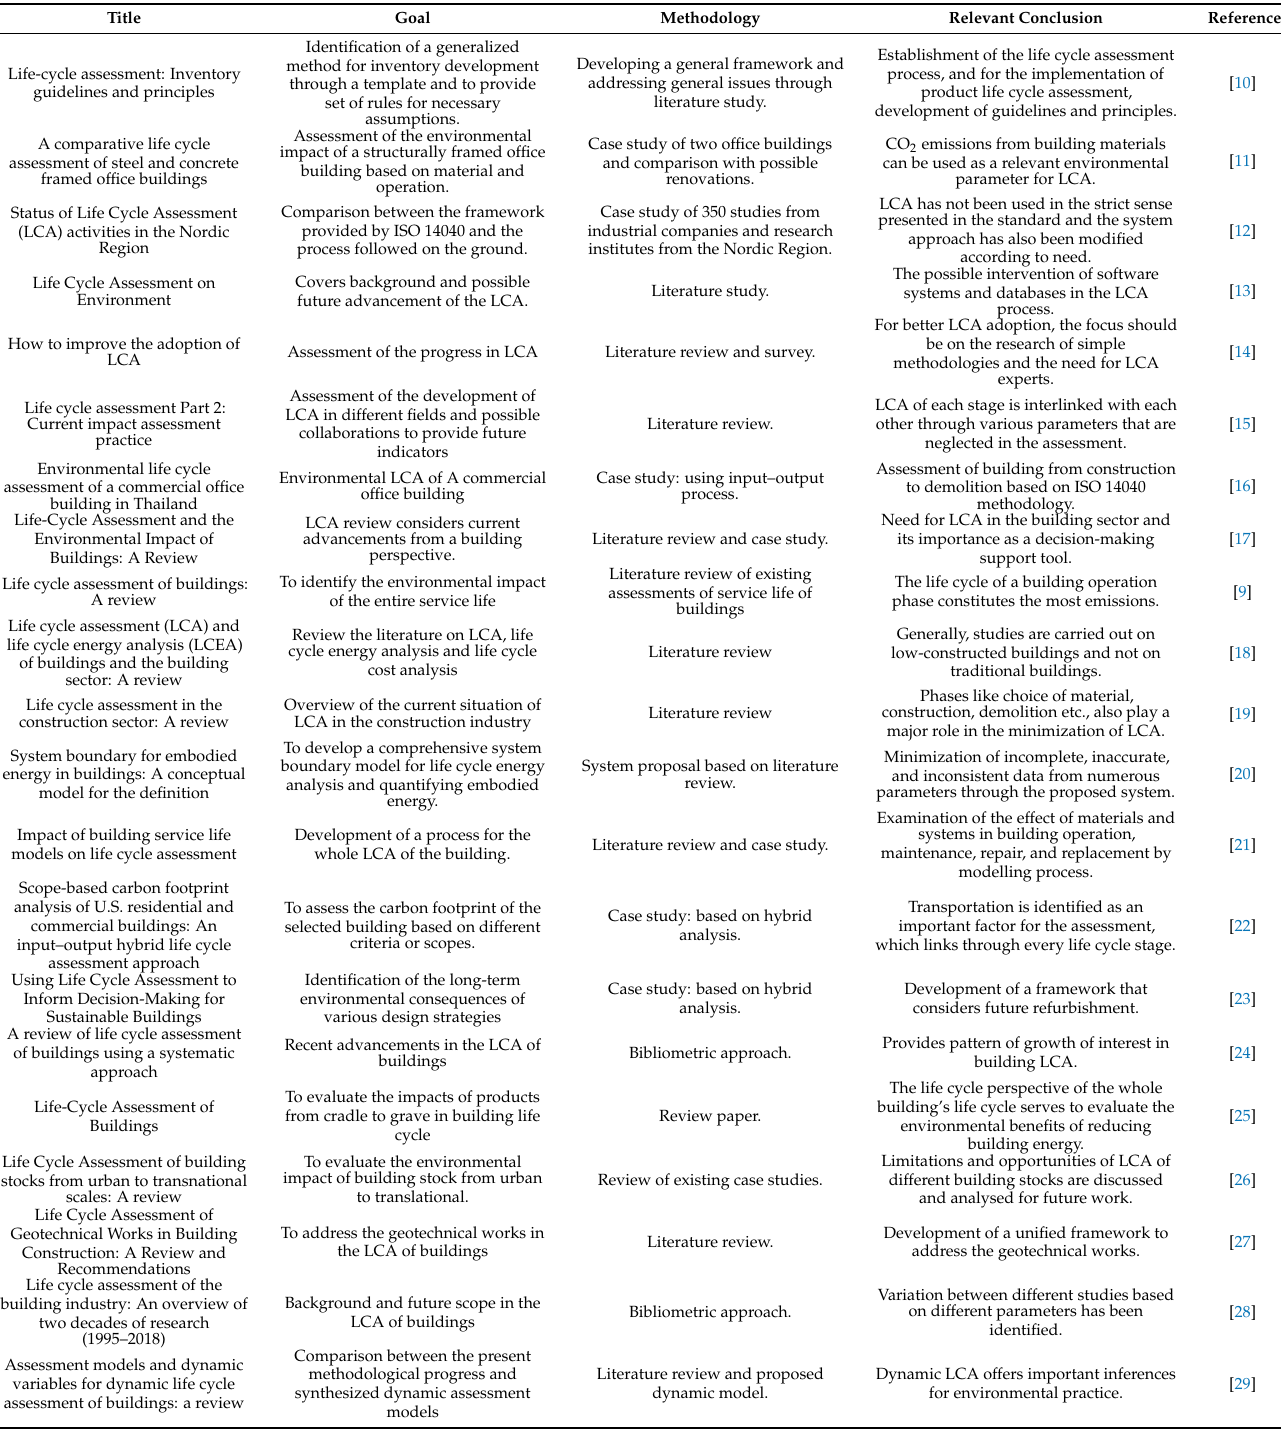
Table 1. Assessment of the approaches and advancement in LCA of